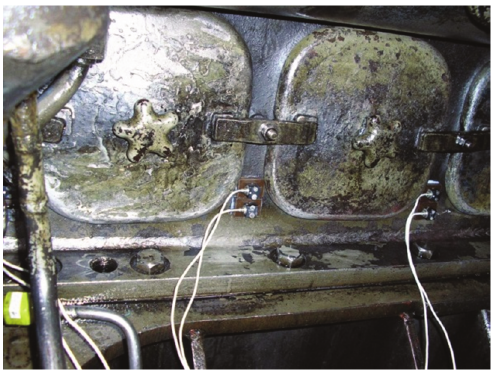
Fig. 1. The example vibration sensors mounted on an engine body in a diagnostic station [1]